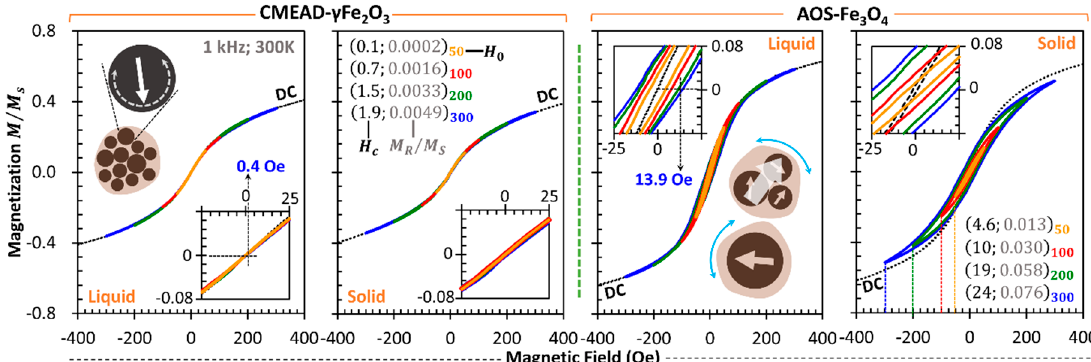
Figure 2. Dynamic magnetization curves of the ferrofluid samples at 1 kHz. The different coercive fields H C and remanences M R within low-field regimes (e.g., ± 50, ± 100, ± 200, and ± 300 Oe) indicate magnetization reversal. The measured magnetization M has been normalized by the saturated magnetization M S of the respective samples. Nanomaterials 2018 , 8 , x FOR PEER REVIEW